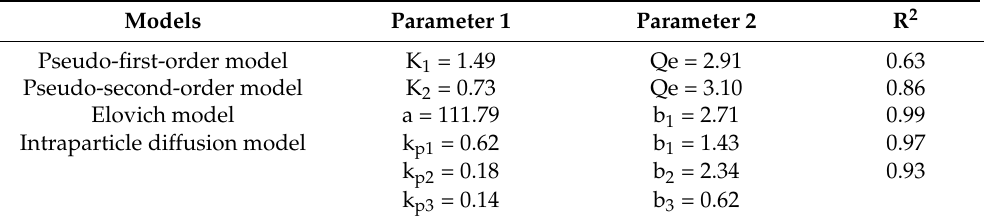
Figure 8. Adsorption kinetics fitting curves by pseudo-first-order kinetics, pseudo-second-order kinetics and Elovich model ( a ) and intraparticle diffusion model ( b ). Table 2. Calculation parameters of kinetics model of phosphate recovery.